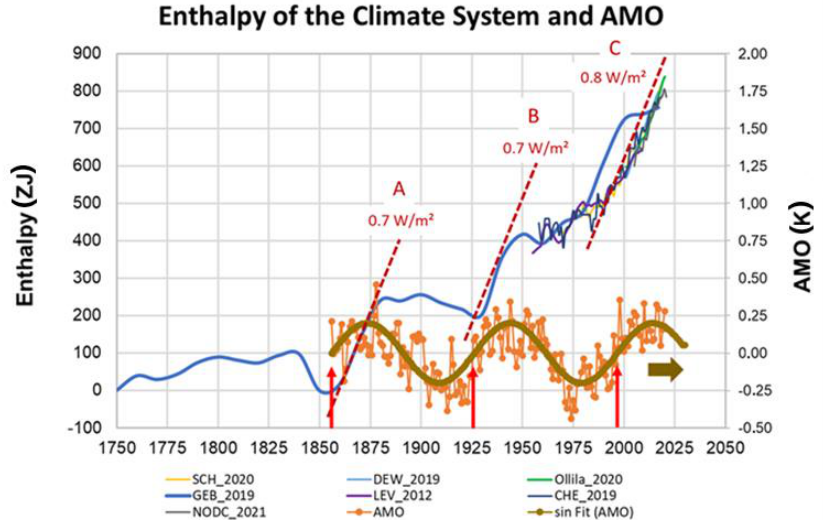
Figure 13. Climate system enthalpy since 1750, reconstructed from radiative and ocean heat data taken from the publications of Schuckmann et al. [13], Ollila [18], Dewitte et al. [15], Levitus et al. [7] and NODC [7], Cheng et al. [10], Gebbie and Huybers [11] and this work. The OHC-Data were divided by 0.9. The two heating impulses A and B had a span of about 25 years, and similarly, high net fluxes as the presently observed phase C. The zero levels of the enthalpy datasets was set to match. The AMO values were downloaded from http://www.psl.noaa.gov/data/timeseries/AMO/ (accessed on 29 July 2021) and transformed into annual averages. A sine-fit is added to the AMO-data (right scale). The arrows at ca. 1860, 1925 and 2000 indicate the sign change of the AMO-Index from negative to positive.